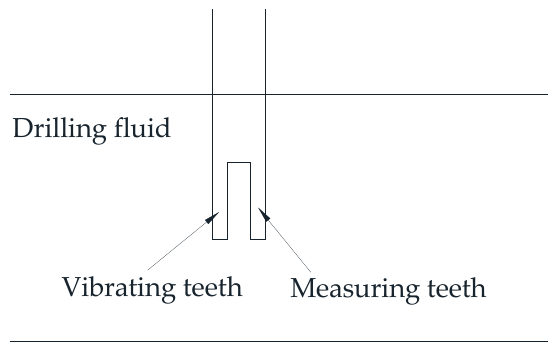
Figure 8. Tuning fork technology.